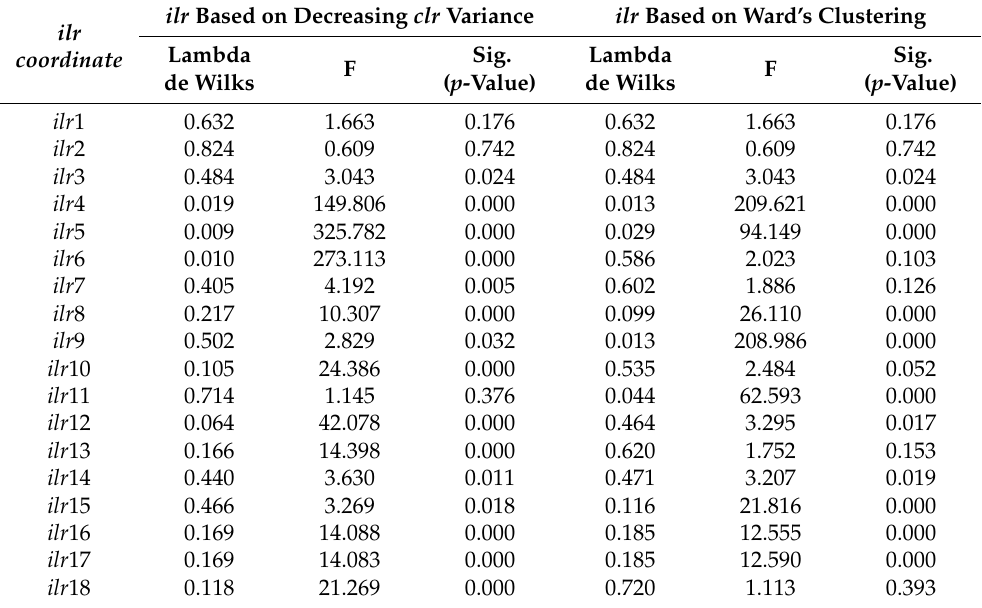
Table 5. One-way ANOVA for testing significant differences among treatments, based on ilr coordinates obtained following clr variance and Ward’s clustering